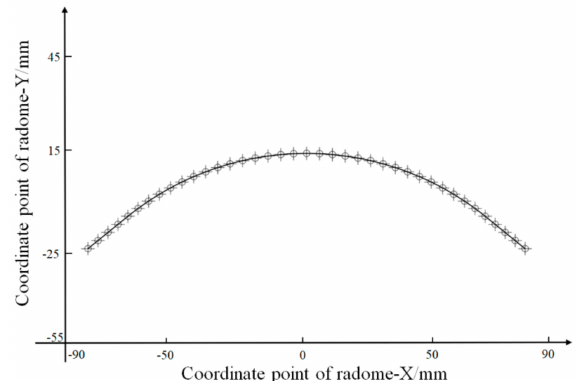
Figure 7. Curve coordinate point line uniformity division diagram.